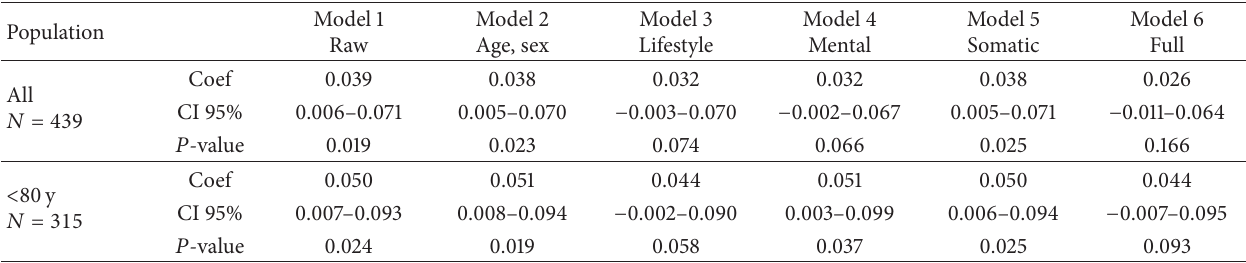
Table 3: The association between LTL and fatigue.